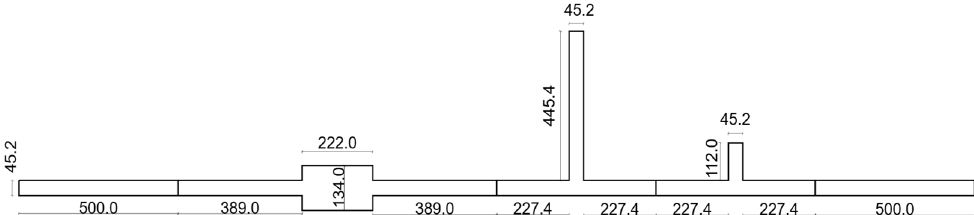
Figure 13. Sketch of the implementation of the silencer system proposed by the first group. The source is placed at the left side and the outlet at the right side.